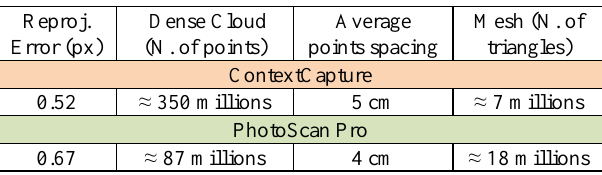
Table 1. Quality indicators of the images processing.